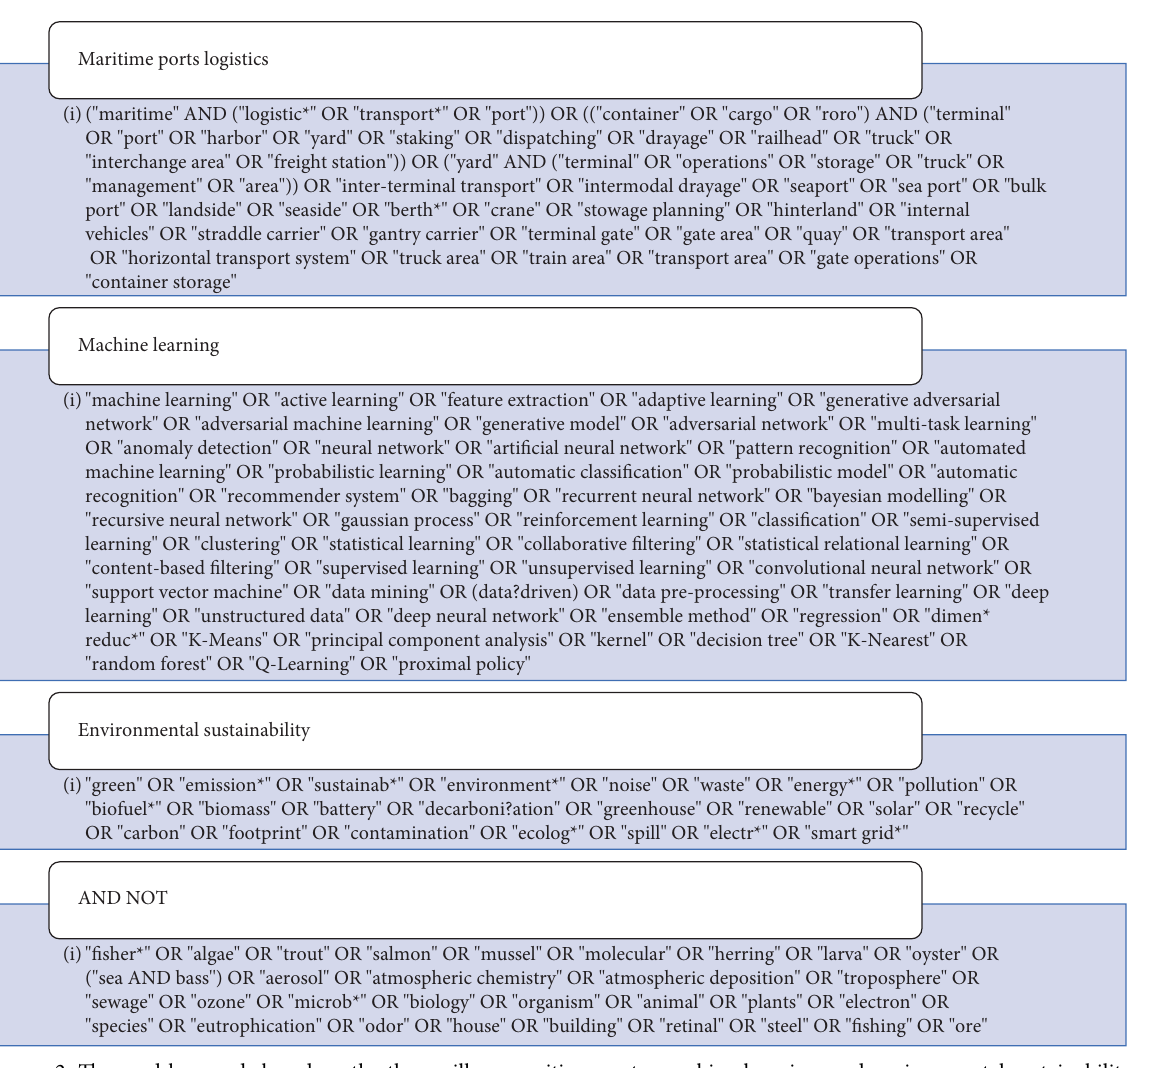
Figure 2: Te used keywords based on the three pillars: maritime ports, machine learning, and environmental sustainability.